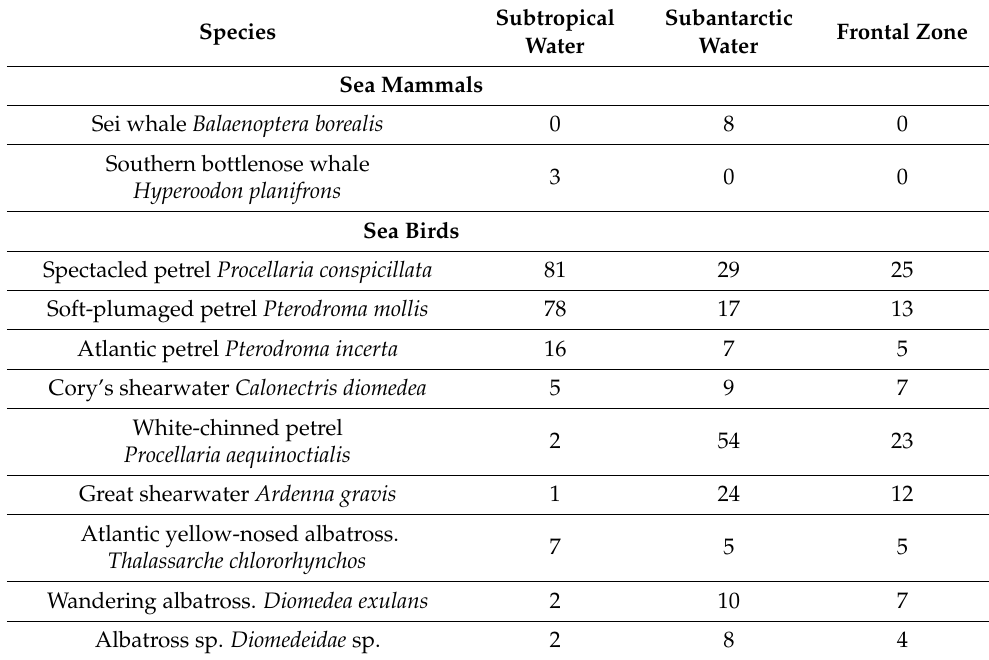
Table 3. Species composition (number of individuals observed) of sea mammals and birds in the rings.